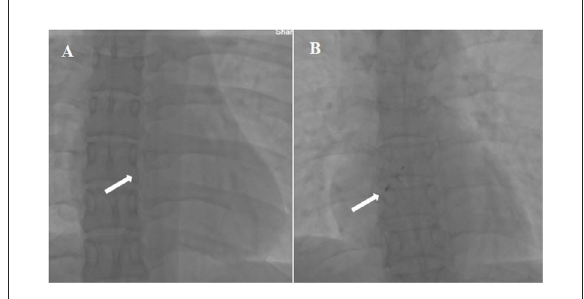
FIGURE7 X-ray appearance of the traditional metal occluder and biodegradable occluder. (A) Non-visualization of degradable occluder on X-ray; (B) conventional metal occluder visualized under